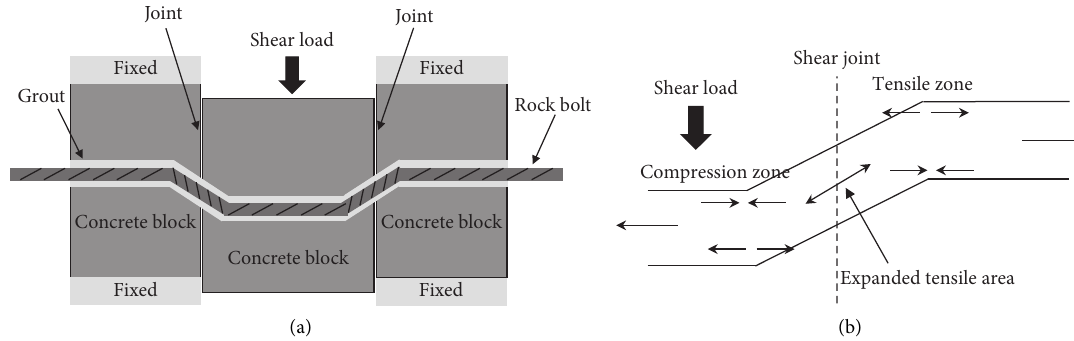
Figure 1: Conceptual illustration of double shear test: (a) double shear test; (b) compression and tensile stresses.